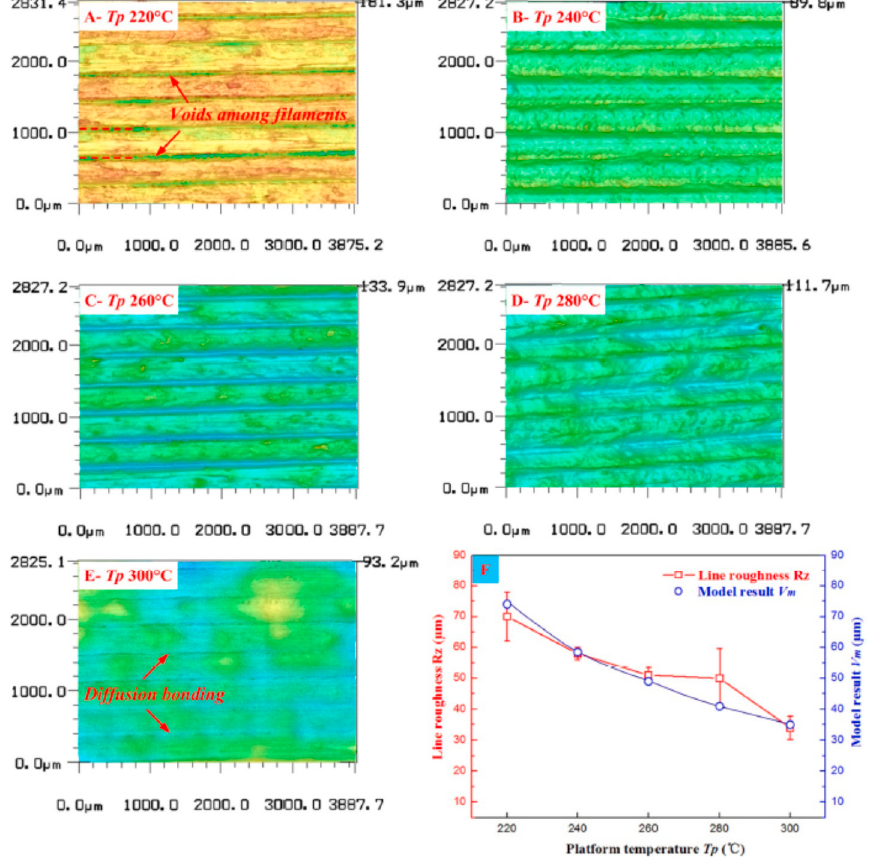
Figure 14. Surface topography of the printed PEEK parts at bed temperatures of ( A ) 220 ◦ C, ( B ) 240 ◦ C, ( C ) 260 ◦ C, ( D ) 280 ◦ C ( E ) 300 ◦ C and ( F ) experimental results and model results of surface roughness in different platform temperatures [109].